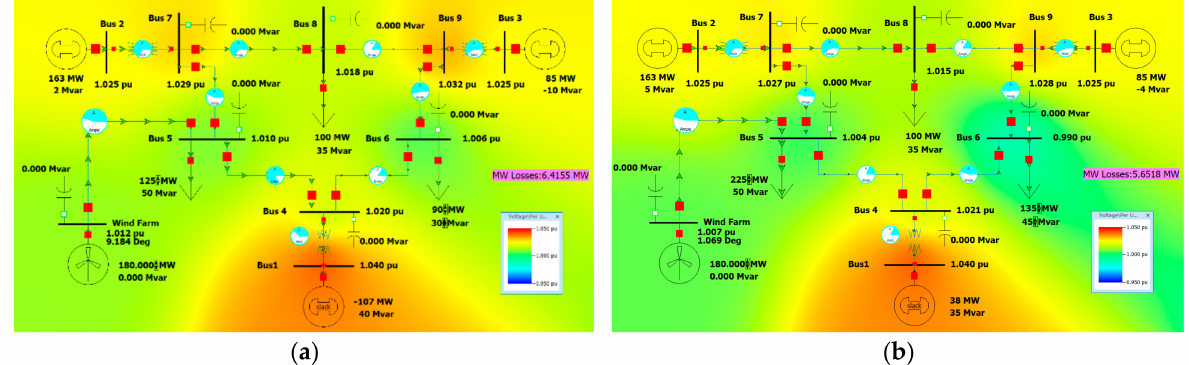
Figure 3. Simulation results with Tower C connected to bus 5 (25 km). ( a ) The results under the minimum load condition and ( b ) the results under the maximum load condition.